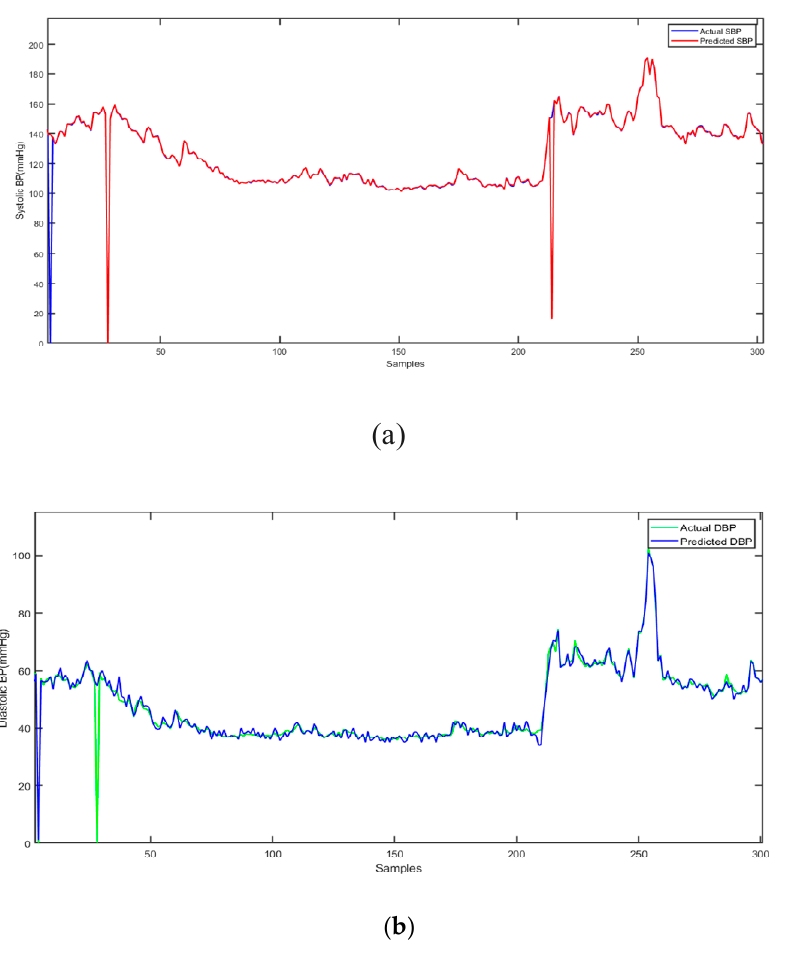
Figure 8. Comparison between ( a ) actual (blue) and predicted (red) SBP; ( b ) actual (green) and predicted (blue) DBP.